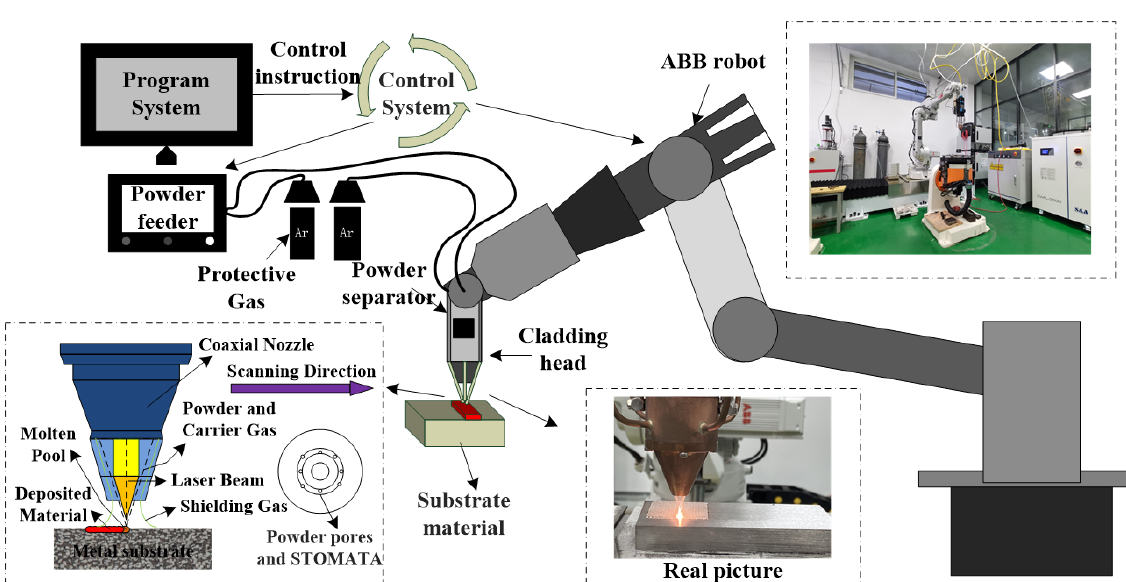
Figure 2. Schematic diagram of cladding equipment.